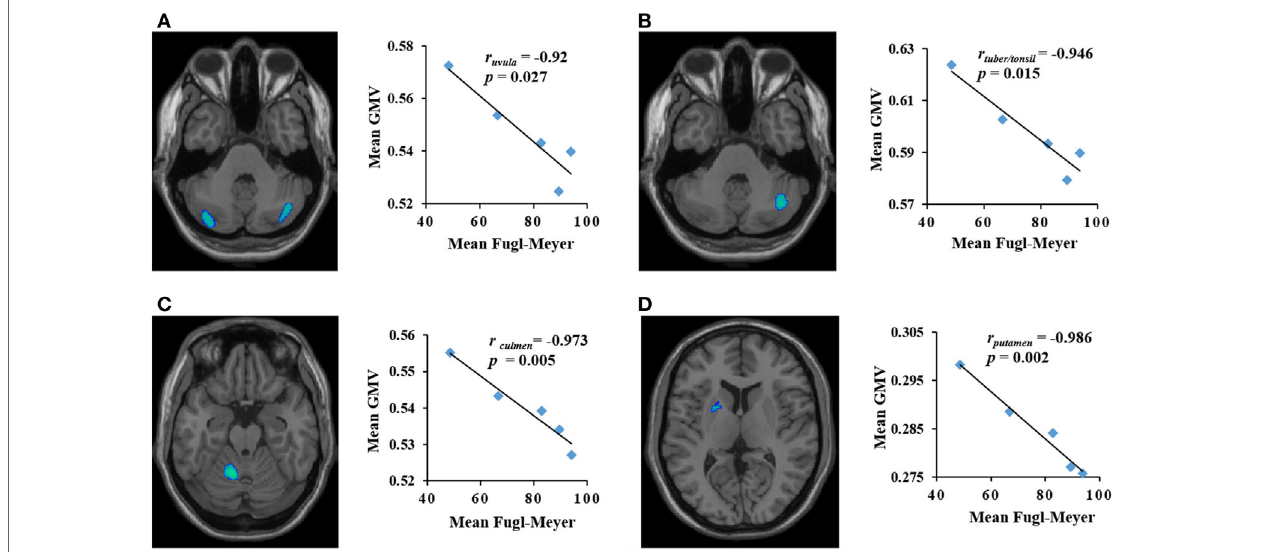
FigUre 3 | The brain areas with decreased gray matter volume (GMV) ( y -axis) were negatively correlated with Fugl-Meyer score ( x -axis) in patients with pontine infarction during the period of observation. r indicates Pearson correlation coefficient. (a) Contralateral uvula: r = − 0.92, p = 0.027; (B) ipsilateral tuber/tonsil: r = − 0.946, p = 0.015; (c) contralateral culmen: r = − 0.973, p = 0.005; (D) contralateral putamen: r = − 0.986, p =